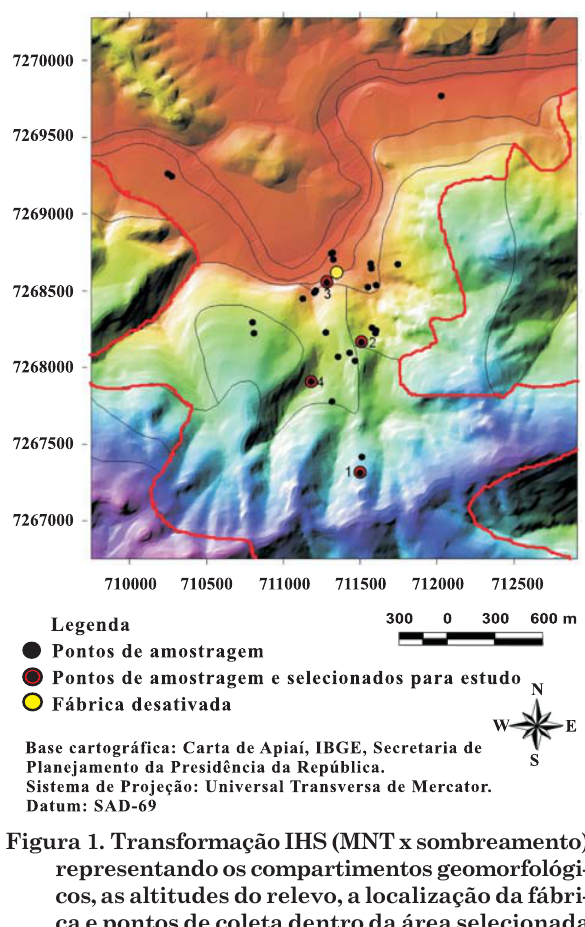
Figura 1. Transformação IHS (MNT x sombreamento) representando os compartimentos geomorfológi- cos, as altitudes do relevo, a localização da fábri- ca e pontos de coleta dentro da área selecionada para o estudo (contorno em vermelho).